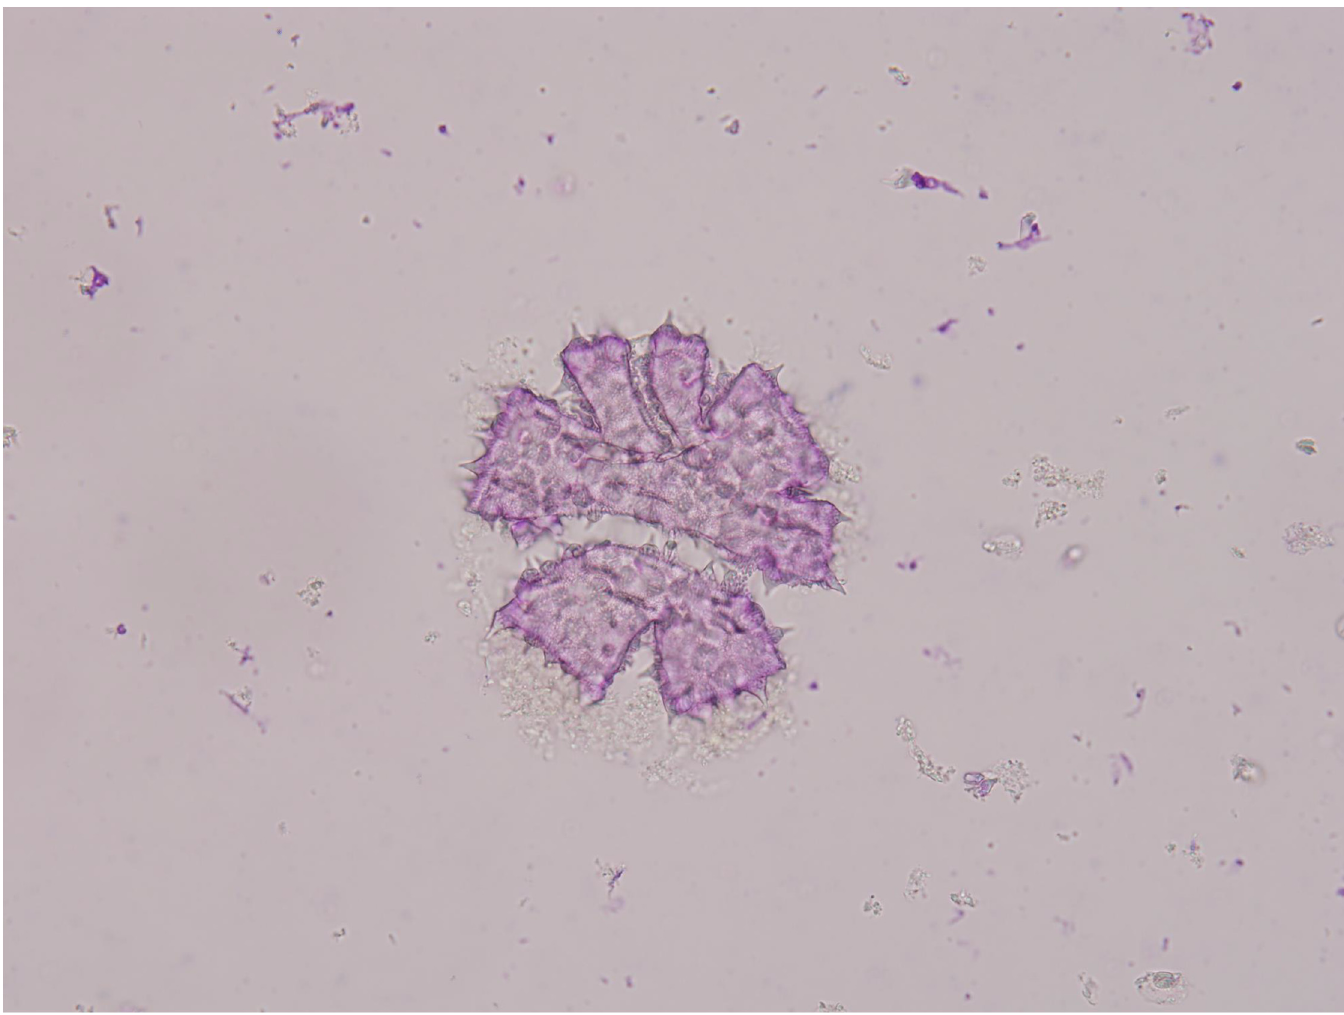
Fig 3. Flower characteristic and leaf performance comparison for this hybrid with three parents (from up to down: G . hirsutum , G . australe , allohexaploid, G. capitis-viridis and triple hybrid